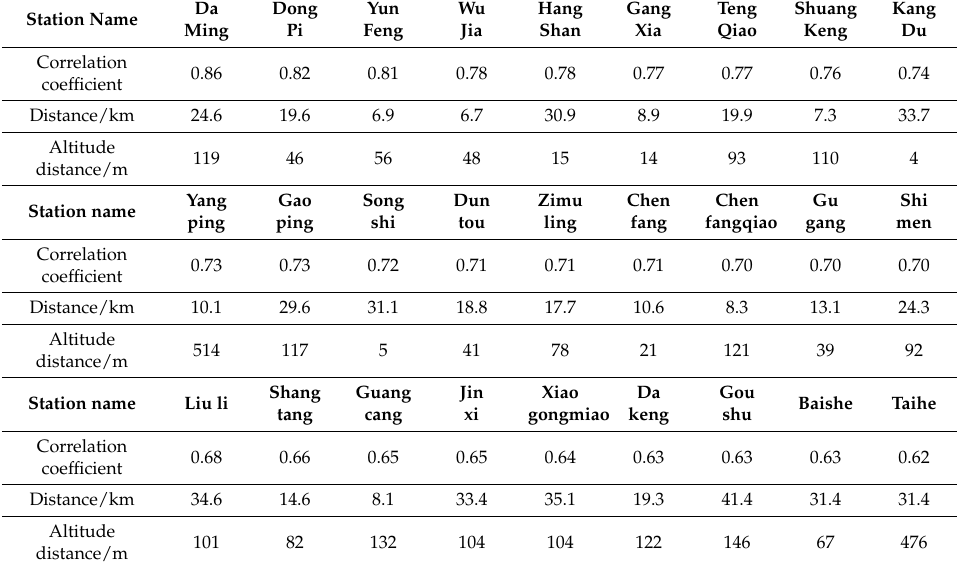
Table 3. Correlation coefficient and distance table for candidate